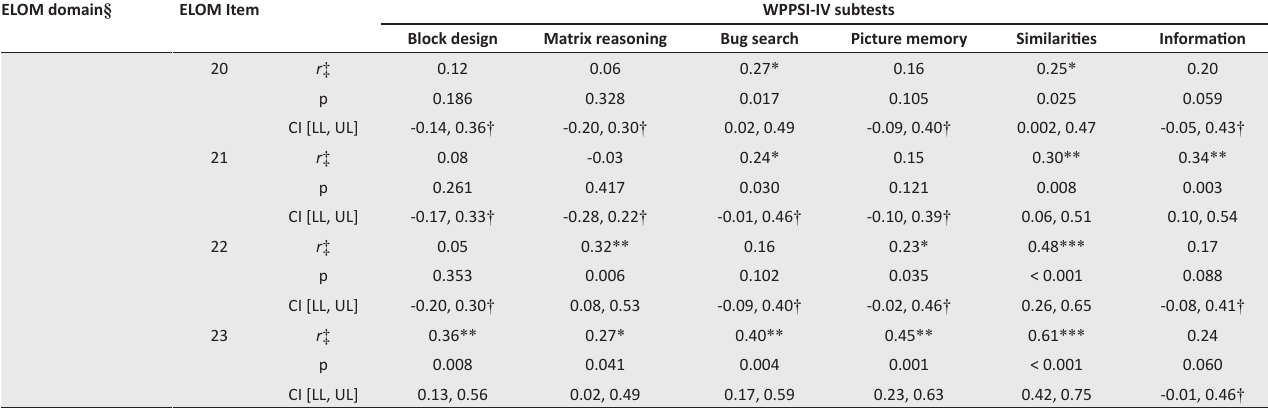
TABLE 9 (continues…): Correlations of ELOM items and WPPSI-IV subtests. ELOM domain § ELOM